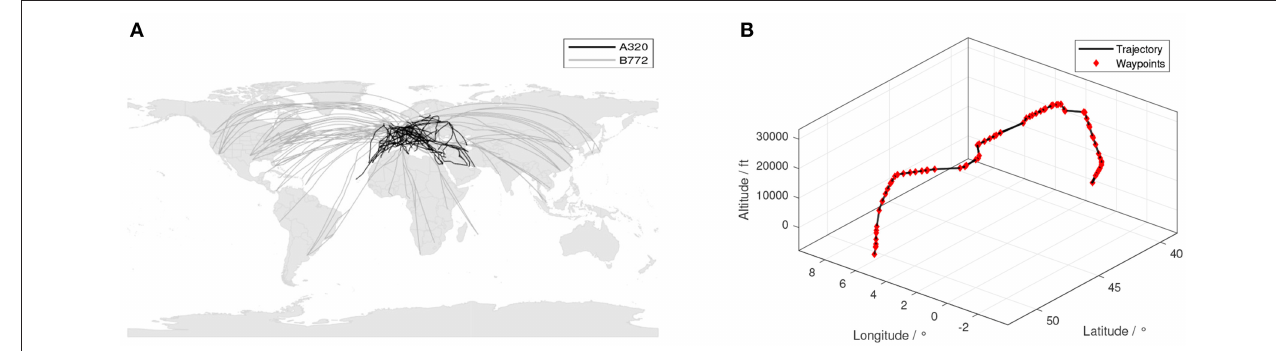
FIGURE 1 | (A) Flight trajectories for two different aircraft types (August 25, 2018), (B) Calculated 4D aircraft flight trajectory using waypoints from initial flight